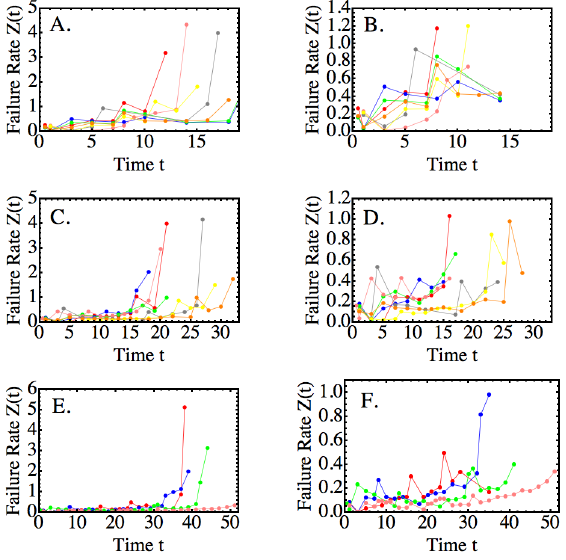
Figure 4. Failure Rate Kinetics of Long-term Repopulating HSCs. To facilitate visualization, failure rate kinetics (vertical axes: each colored line-scatter curve represents the failure rates of the total output of an individual HSC) were displayed in three non-classifying groups (rows A–B, C–D, E–F) and at two levels of resolution (full kinetics in column A, C, E; (0,2) -truncated kinetics in column B, D, F) over time (horizontal axes). The full kinetics show that the failure rates increase strongly as the lifespan is approached. We called this behavior the ‘‘extinction transition’’. The (0,2) -truncated kinetics illustrate the variability, and a tendency to slowly increase, of the failure rates prior to reaching the extinction transition.